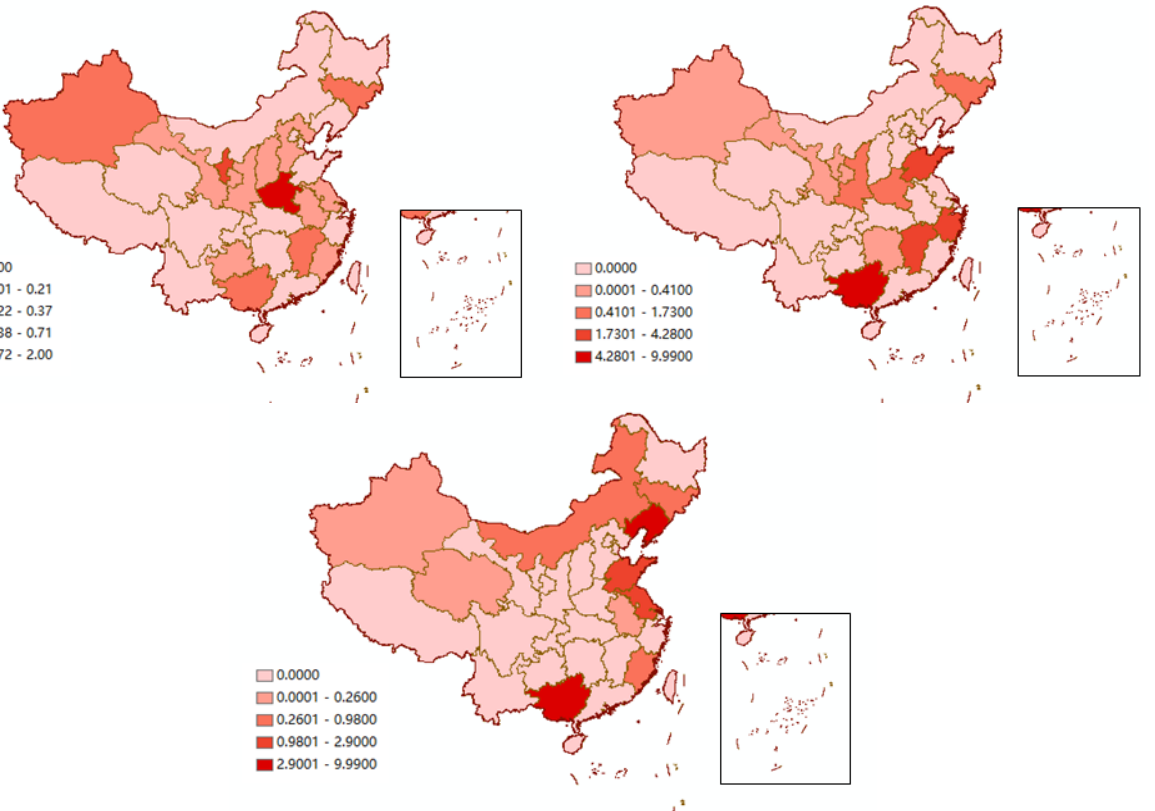
Figure 8. Increase in carbon transfer from pilot areas to non-pilot areas from 2012–2017 (unit: MtCO 2 ). From left to right and from top to bottom: the increase in non-pilot carbon transfer from pilot areas in the chemical, building materials, and metal industries from